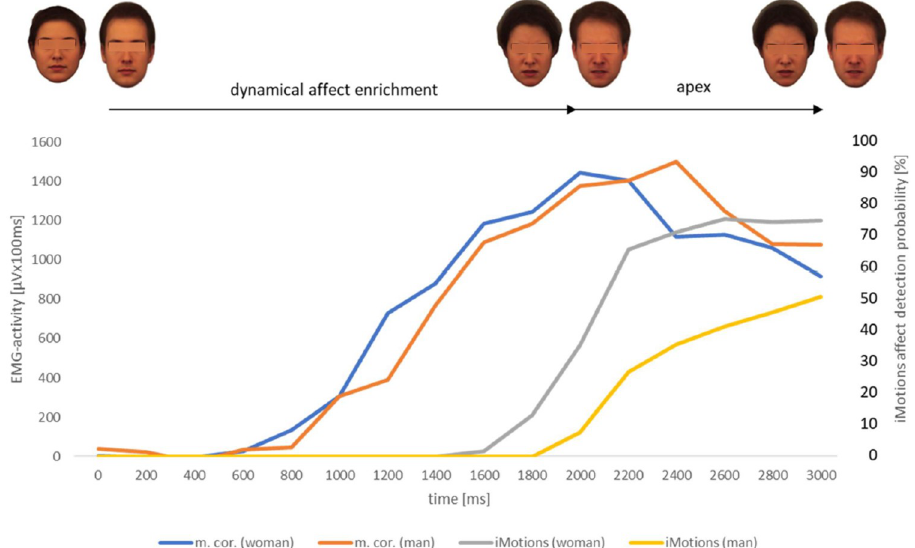
Fig 9. EMG-activity (N = 43) of m. corrugator [ μ Vx100ms] of healthy observers in response to the presented videoclips displaying the facial expression of anger naturalistic evolving from a neutral face of the female respective male reference portrait; software based (AFFDEX/iMotions) affect detection probability values [%] of the same presented stimuli; measurement interval for both procedures 3000ms. m.cor. (woman) = EMG-activity of musculus corrugator in response to the adult female face video. m.cor. (man) = EMG-activity of musculus corrugator in response to the adult male face video. iMotions (woman) = software based affect detection probability [%] in response to the adult female face video. iMotions (man) = software based affect detection probability [%] in response to the adult male face video.